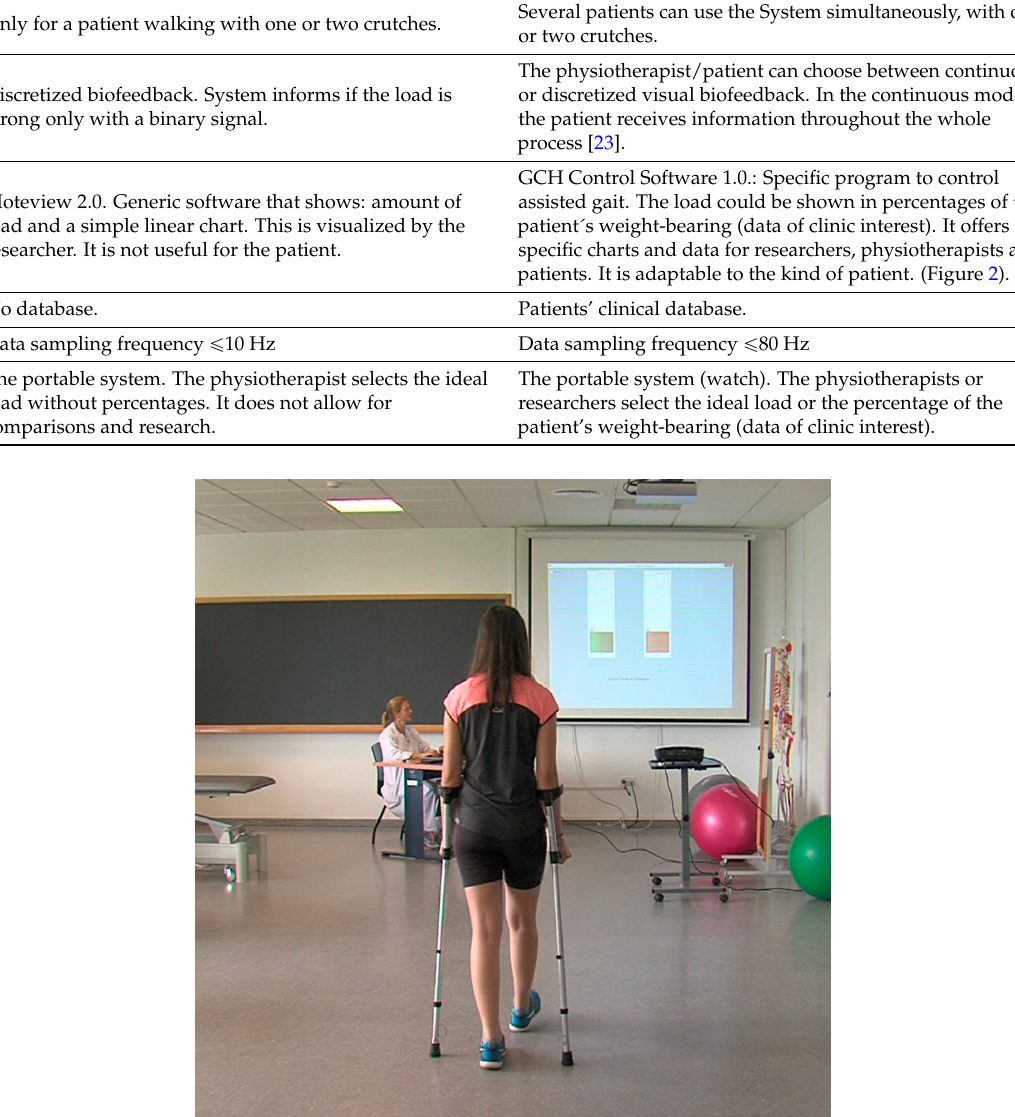
Figure 2. Individual walking while the quantity of the load exerted on the crutches is observed on the screen to improve its accuracy. The image on the board, which is different from the computer